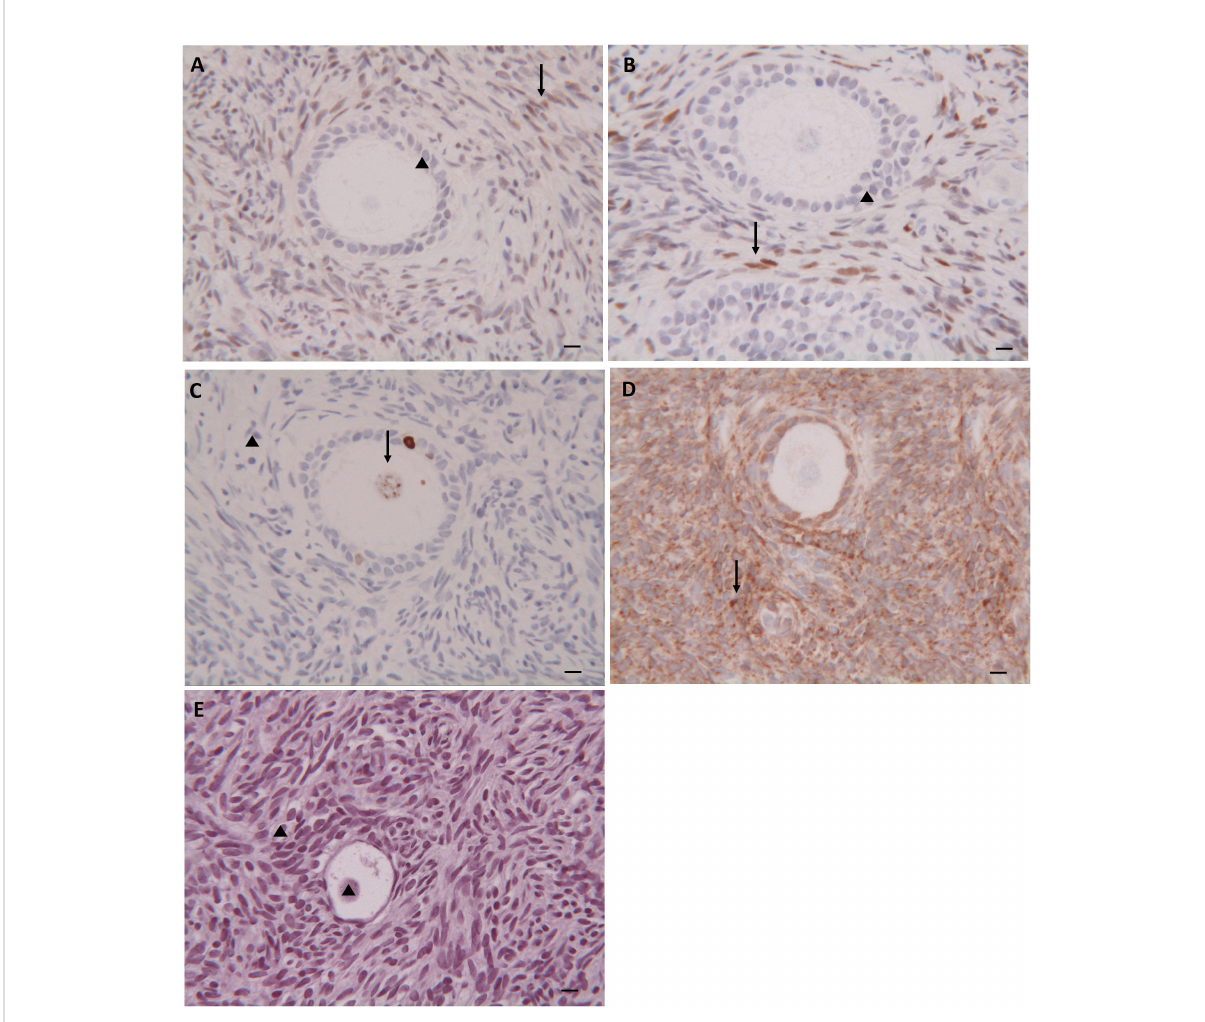
FIGURE 3 Immunohistochemical Analysis. Immunohistochemical staining for estogen (A) , progesterone (B) , ki-67 (C) , bcl2 (D) and TUNEL (E) in follicles and stroma of thawed ovarian tissue. ( ▲ ) Negative staining; ( ↑ ) Positive staining. Scale Bar 25